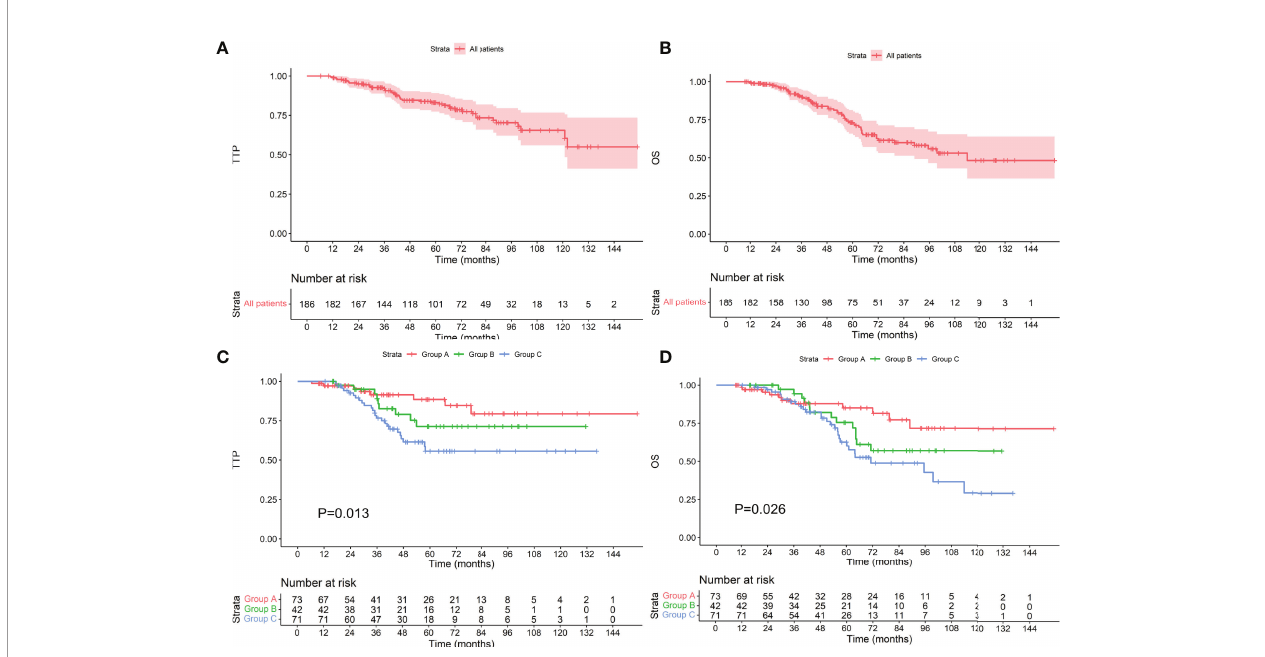
FIGURE 2 | TTP (A) and OS (B) for all patients included. TTP (C) and OS (D) for patients who achieved an MRD-negative status at different stages. The Group A, Group B, and Group C represent achieving an MRD-negative status after induction therapy, ASCT, and maintenance therapy, respectively (the same below).